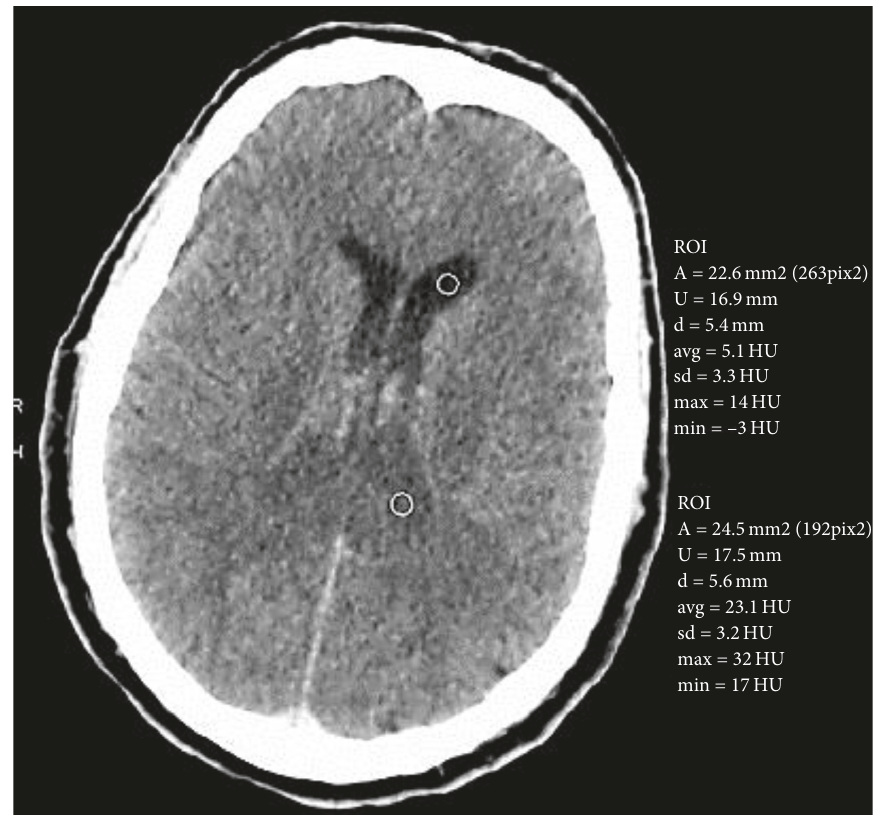
Figure 2: Cranial CT reveals hyperdense sedimentations (Hounsfield unit (HU) 23) in both posterior lateral ventricles, suggesting haemorrhage or pus.